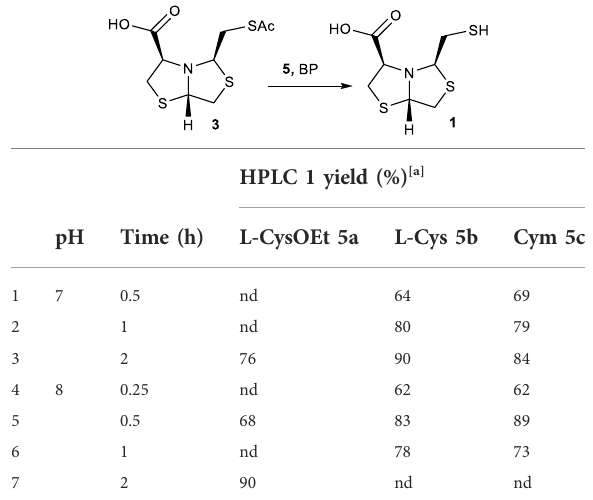
TABLE 1 Optimization of thioester deprotection using different 2- aminothiols 5a-c for the deprotection of